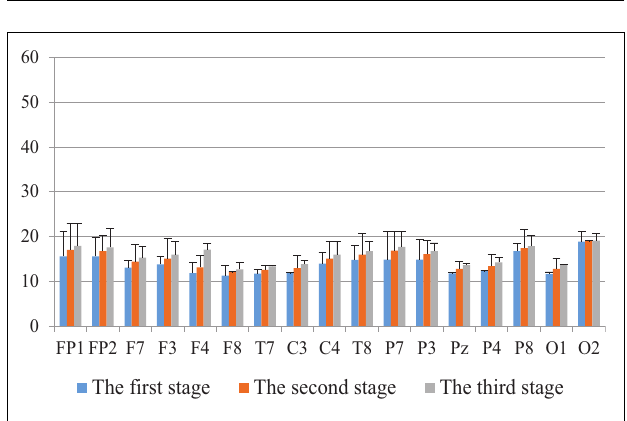
FIGURE 9 | The characteristics of gamma wave power changes in whole brain area of healthy subjects in the three experimental stages.